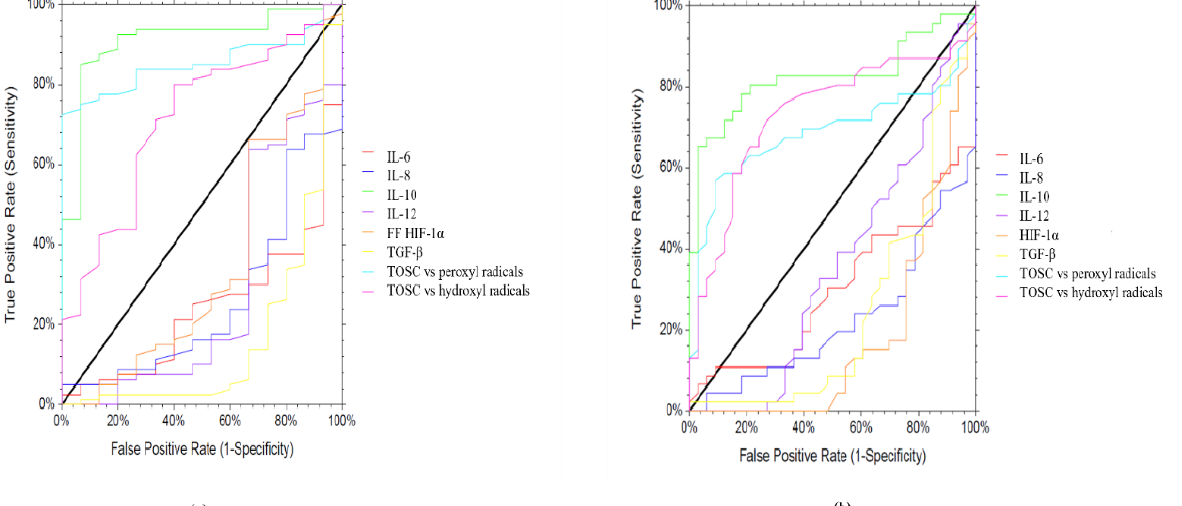
Figure 3. ROC analyses of FF biochemicals ’ parameters were carried out to evaluate the capacity to differentiate fertilized oocytes from unfertilized ones ( a ), and top-quality embryos from poor-quality ones ( b ). AUROC and CI values are reported in Table 3.